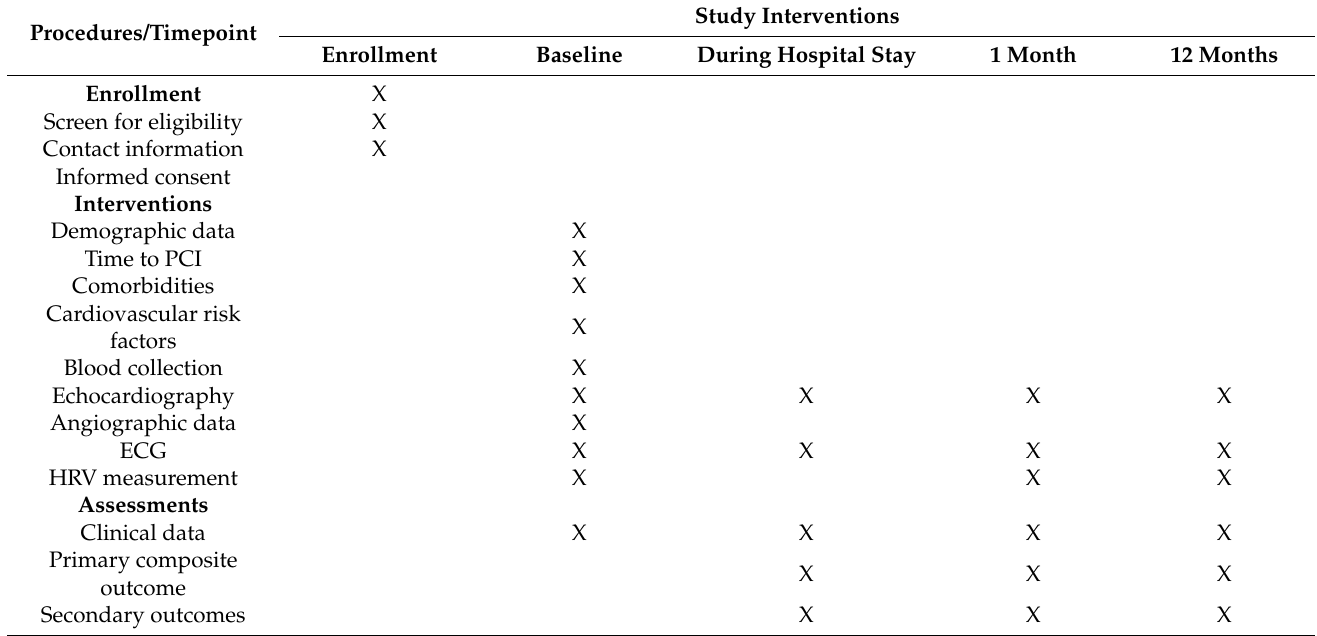
Table 1. Collecting data at specific time